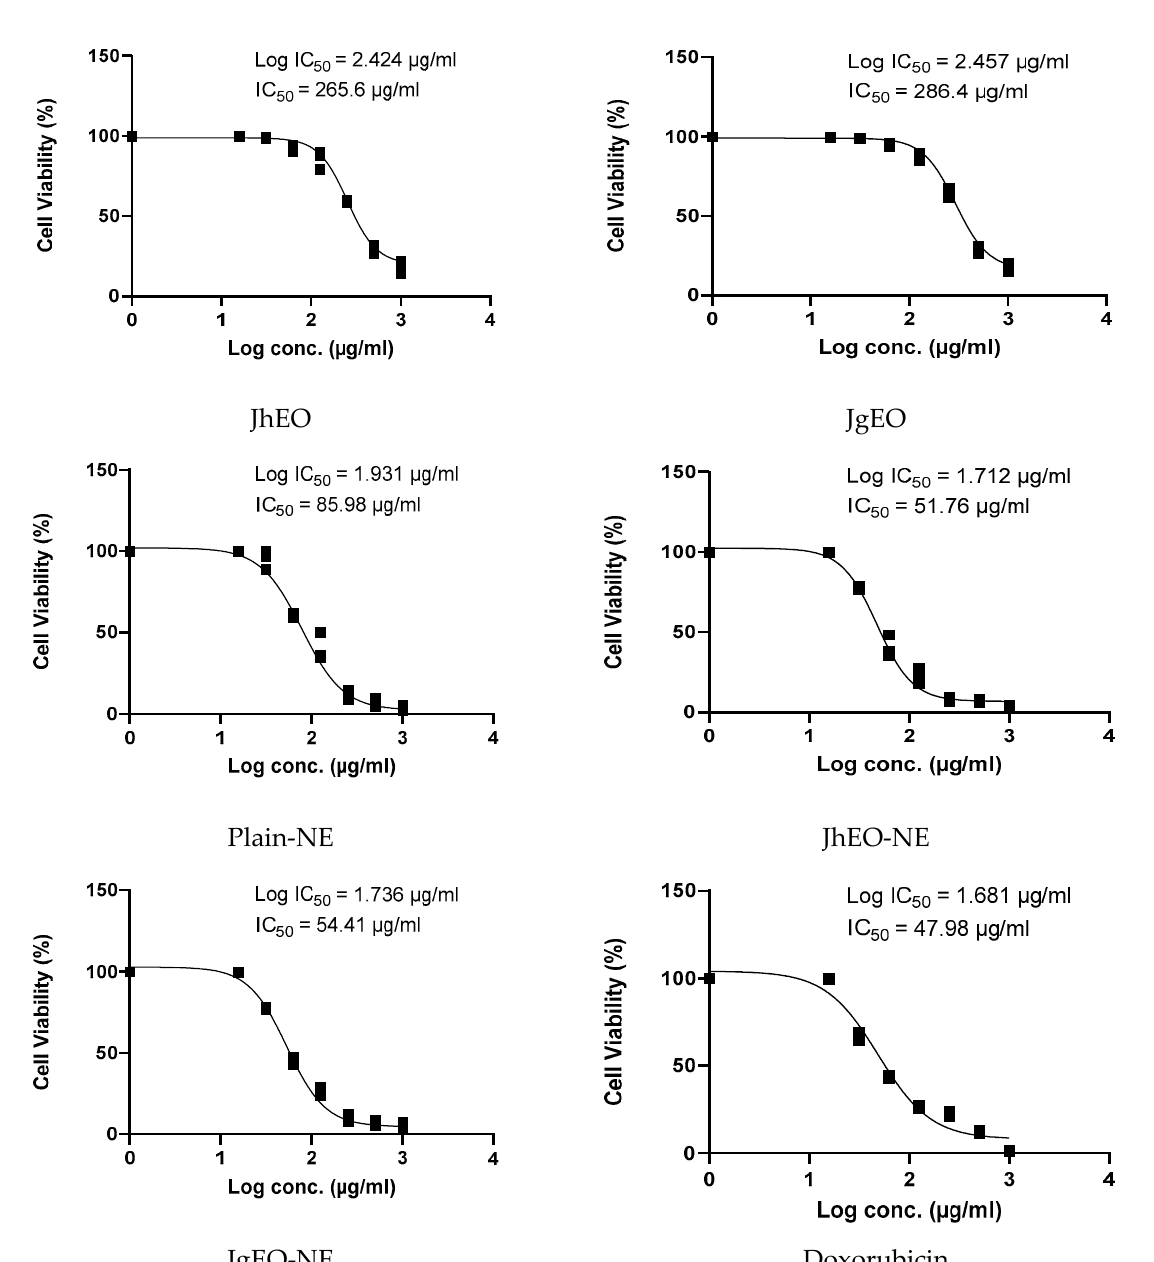
Figure 4. IC 50 of J. humile (JhEO) and J. grandiflorum (JgEO) pure essential oils, their nanoemulsion formulations (JhEO-NE) and (JgEO-NE), plain nanoemulsion formulation (Plain-NE) as well as standard doxorubicin against THP-1 cell